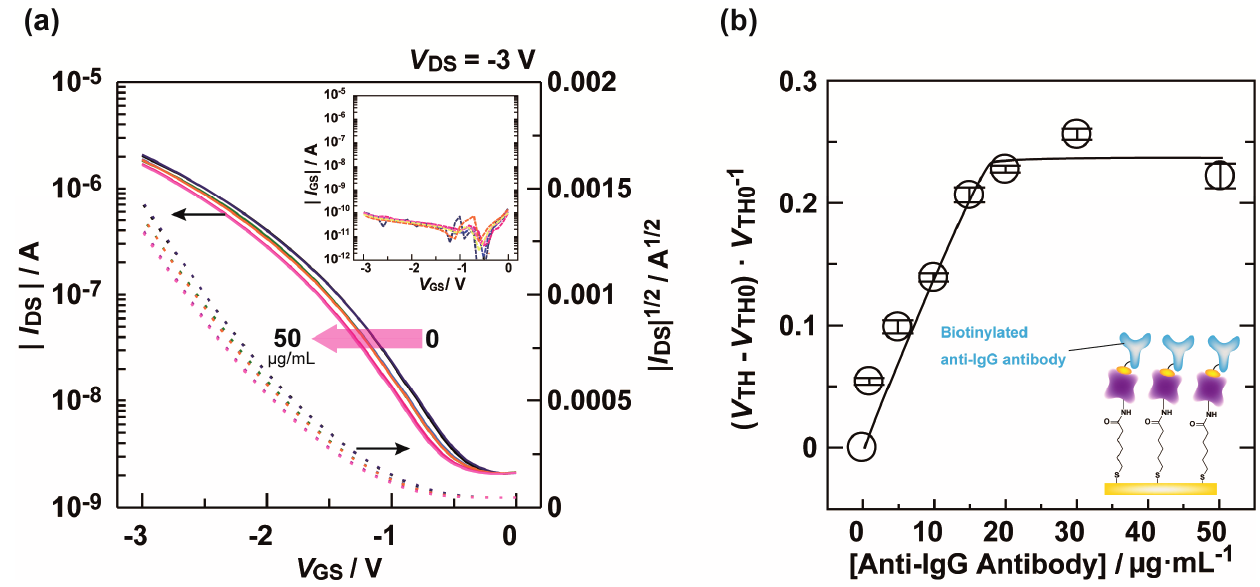
Figure 3. ( a ) Transfer characteristics ( I biotinylated anti-IgG antibody in a D-PBS solution with 0.1 wt% BSA. [Anti-IgG antibody] = 0–50 μ g/mL. The inset shows the gate-source current ( I voltage ( V ) for the OFET by biotinylated anti-IgG antibody at various concentrations in a TH D-PBS solution with 0.1 wt%